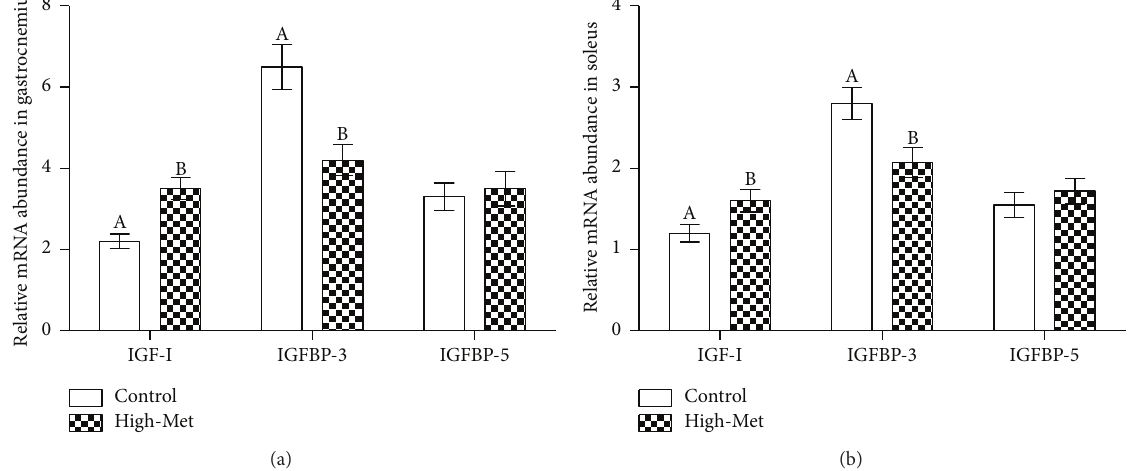
Figure 4: Results of high-Met diet upon the level of mRNA in gastrocnemius (a) and soleus (b). Data is presented as means ± SEM ( 𝑛 = 8 ). A , B The varying characters indicate the statistically significant differences between the high-Met and control groups ( P <